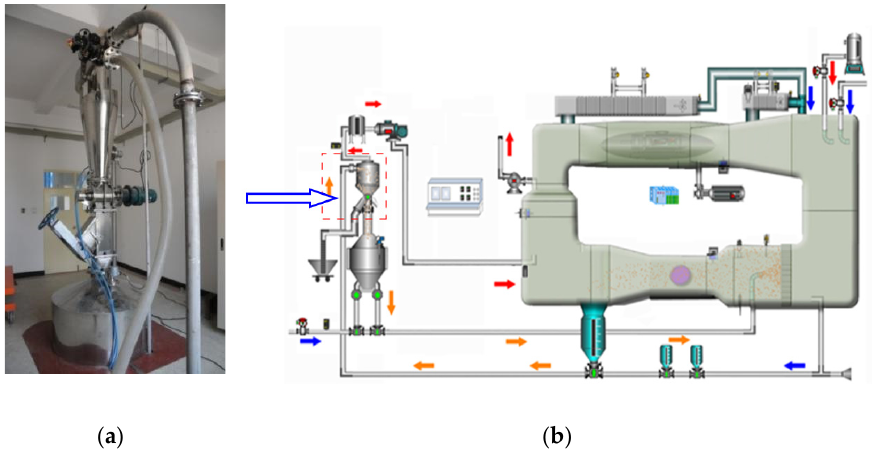
Figure 1. ( a ) Appearance of the pneumatic conveyance component; ( b ) Flow chart for the pneumatic conveyance control system.